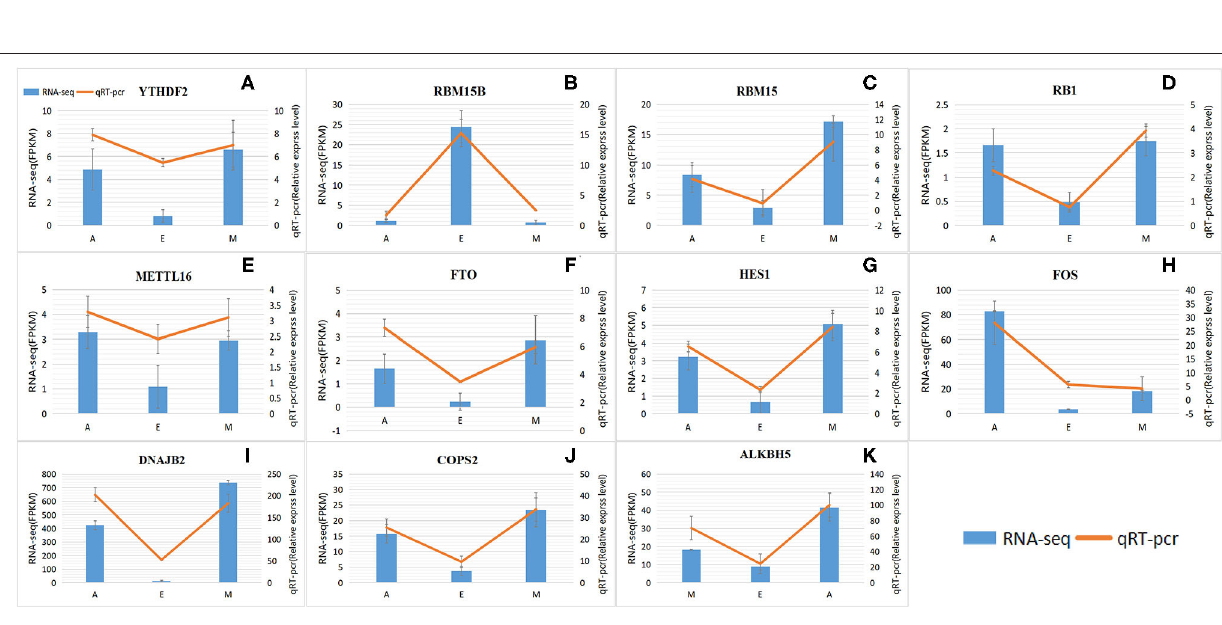
FIGURE 7 | Levels of RNA methylation-related genes validated by quantitative real-time polymerase chain reaction (qRT-PCR). (A–K) RNA-Seq results are shown as a bar graph. The value to the right of the y -axis represents FPKM. The qRT-PCR results are shown in the line graph, with the y -axis on the left representing the relative expression level. Data represent mean ± standard error